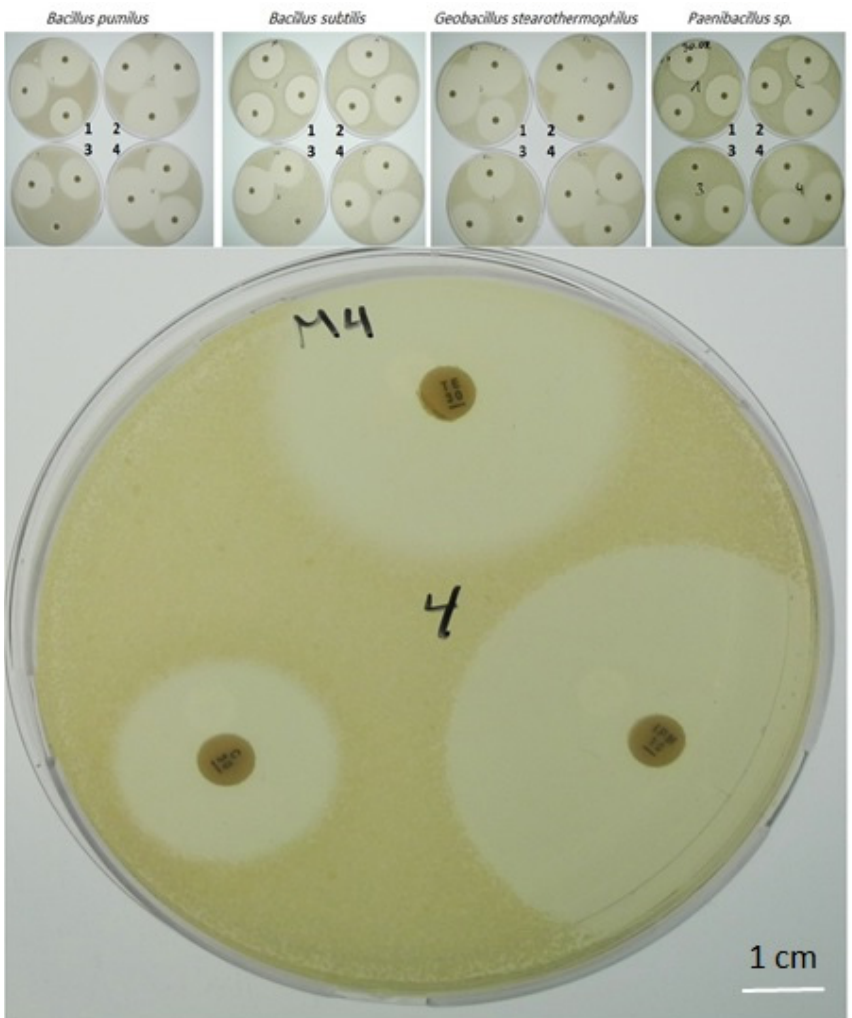
Figure 4. Representative results for an antibiotic susceptibility profile showing the zones of inhibition obtained on Mueller–Hinton (MH) agar for bacterial isolates from banana in vitro plants. Plates coded 1, 2, 3, and 4 represent four different antibiotic groups: (1) Oxacillin, Penicillin G, and Ampicillin; (2) Mezlocillin, Ticarcillin, and Cefalotin; (3) Aztreonam, Cefotaxime, and Cefazolin; (4) Chloramphenicol, Imipenem, and Tetracycline.